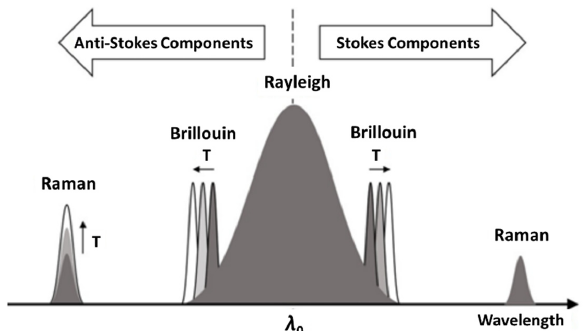
Figure 13. Three kinds of backscattered optical signals and their responses to temperature changes. (Reprinted by permission from Springer Nature: A review on optical fiber sensors for environmental monitoring, H. Joe, et al, 2018 [47]).